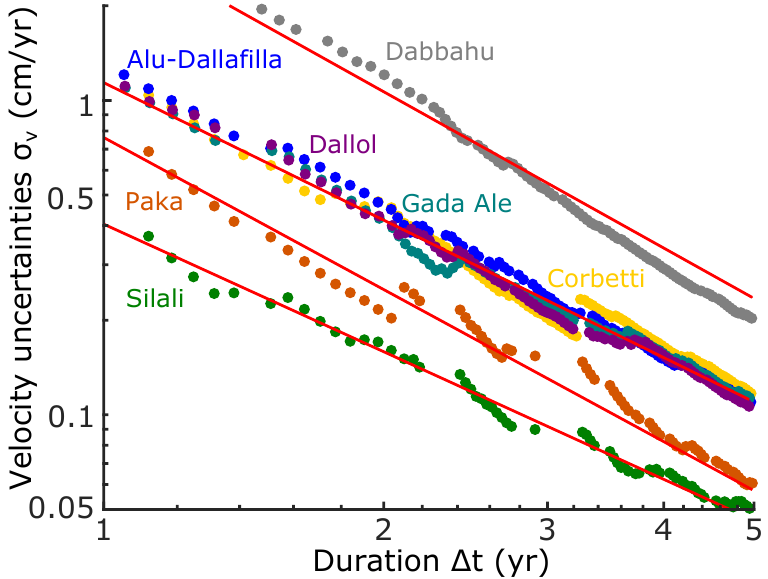
Figure 7. LOS velocity uncertainties σ v as a function of the duration of the InSAR time series ∆ t (log- log scale) for the seven volcanoes showing persistent linear displacements for the period 2015–2020: Dabbahu, Alu-Dallafilla, Dallol, Gada Ale, Corbetti, Paka and Silali. Linear trends are an indication of a power-law relationship: σ v = a ∆ t − b , where a corresponds to the LOS velocity uncertainties after a 1-year period and b the decay rate (Table